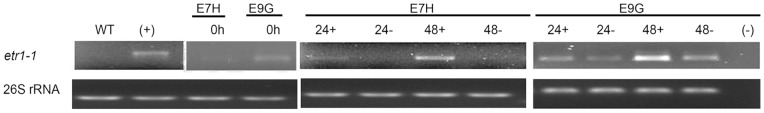
Semi-quantitative RT-PCR analysis of transcript levels of induced etr1-1 gene expression.Petals of transgenic lines E7H and E9G were collected at 0h, 24 h and 48 h after with (+) or without DEX (−) treatments. WT petals and no template (−) were used as negative controls and plasmid DNA (+) was used as a positive control. 26S rRNA was used as an internal control.